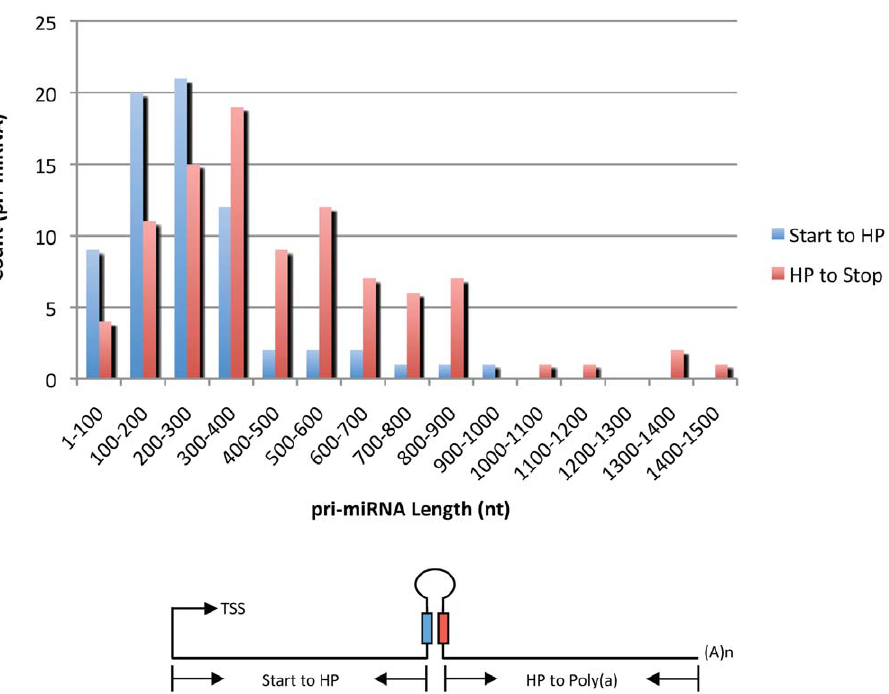
Figure 1. Length distribution of pri-miRNA. Length distribution of 5 9 (blue bars) and 3 9 (red bars) regions of pri-miRNA. The 5 9 region is defined as the segment from the transcription start site to the hairpin structure (HP), while the 3 9 region is the segment between the hairpin structure and the transcription stop site, 3 9 regions are longer, averaging 953nt versus 523nt.